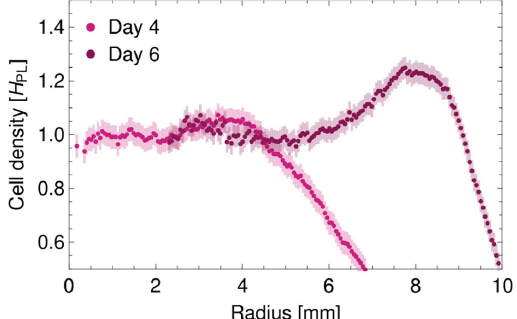
FIG. 14. Evaluation of the colony roughness. We show the edge of the cluster grown on 11 kPa gels and glass, respectively, and FIG. 12. Mobility in the H compartment. Evolution of the P the corresponding fitted circle to evaluate the roughness of the density profile as a function of time for a tissue grown on hard border. The vector r corresponds to the distance of each pixel to gels, at day 4 (light pink) and at day 6 (dark pink). The weak local the circle center, and r is the circle maximum at day 4 is seen to move from 4 mm to the center to c 8 mm to the center at day 6, evidencing the motion of the cell within the H state. Error bars correspond to a typical variation of P (cid:2) 300 cells on the measurement of the density in the segment. The data in the first 2 mm from day 6 were omitted for clarity since, at this distance, the density of the bulk compartment has been achieved.